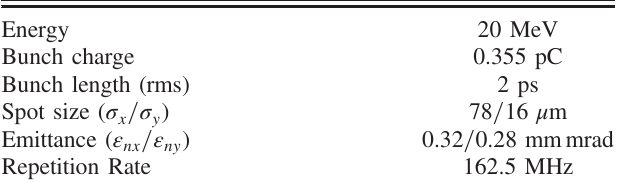
TABLE III. Parameters of the electron beam at the LCS experiment.